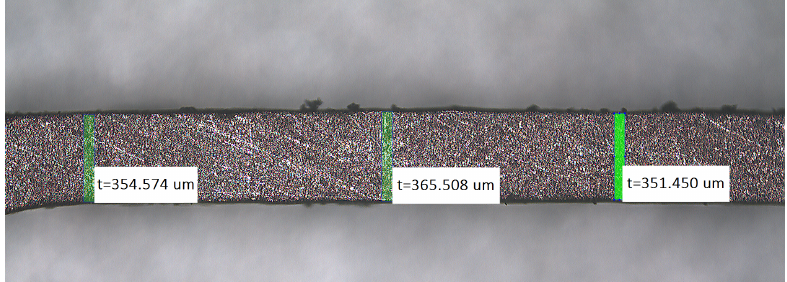
Figure 4. Microscope image of a portion of the manufactured curved beam.